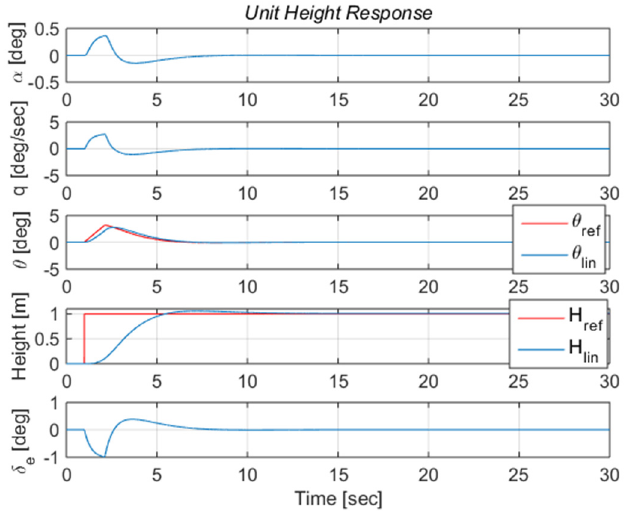
Figure 14. Longitudinal outer-loop step response.